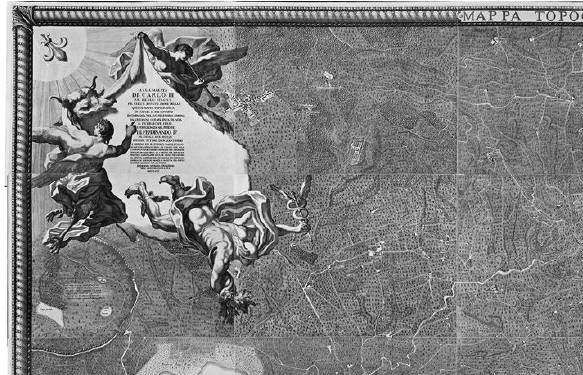
Figure 1. Mappa Topografica della città di Napoli e de’ suoi contorni , G. Carafa Duca di Noja, Naples, 1775. The rural system of the Phlegrean